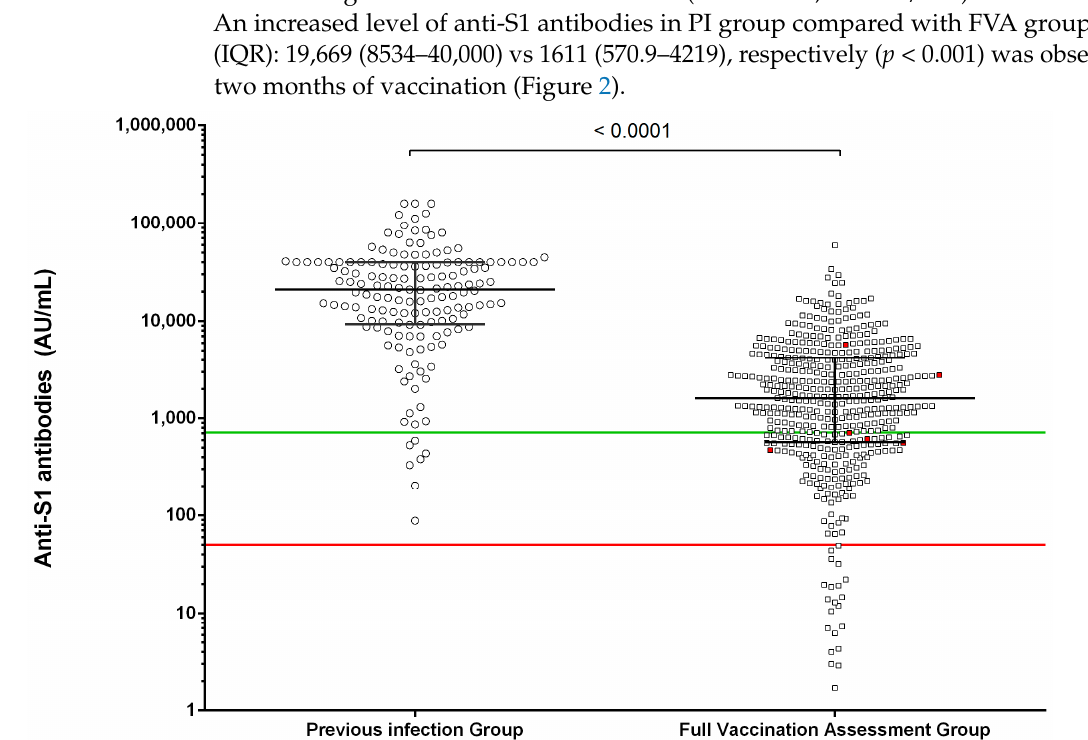
Figure 2. Comparison of anti-S1 antibody levels after two months of BNT162b2 full vaccination in nursing home residents (NHR). The anti-S1 antibody level in the previous infection group (white circles) and full vaccination assessment group (white squares) is depicted. The anti-S1 levels below the red line at 50 AU/mL indicates those NHR identified as seronegative after full vaccination. Whereas a value below 715 AU/mL of anti-S1 antibody level (green line) after two months of vaccination shows patients at risk of infection (red squares). The mean differences were assessed by Student’s t -test.